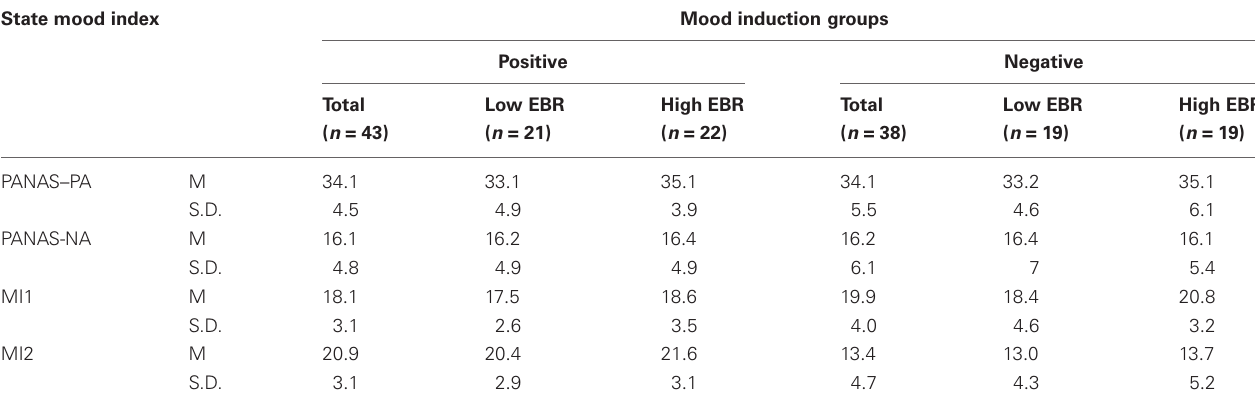
Table 1 | Means and standard deviations for pre-experimental general mood states (PANAS: positive and negative scales), and current mood states (only hedonic valence score) before (MI1) and after (MI2) mood induction in the two experimental groups, and four subgroups, as a function of low vs. (relatively) high pre-experimental eye blink rate (EBR).